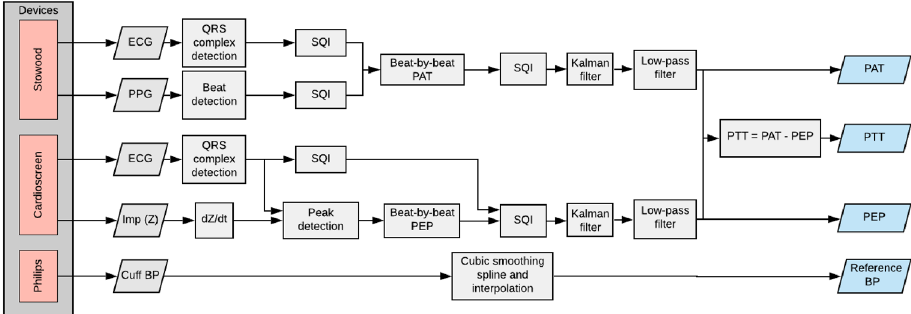
Figure 9. Overview of steps for estimating PAT, PEP and PTT and for processing the reference blood pressure signal from the blood pressure cuff